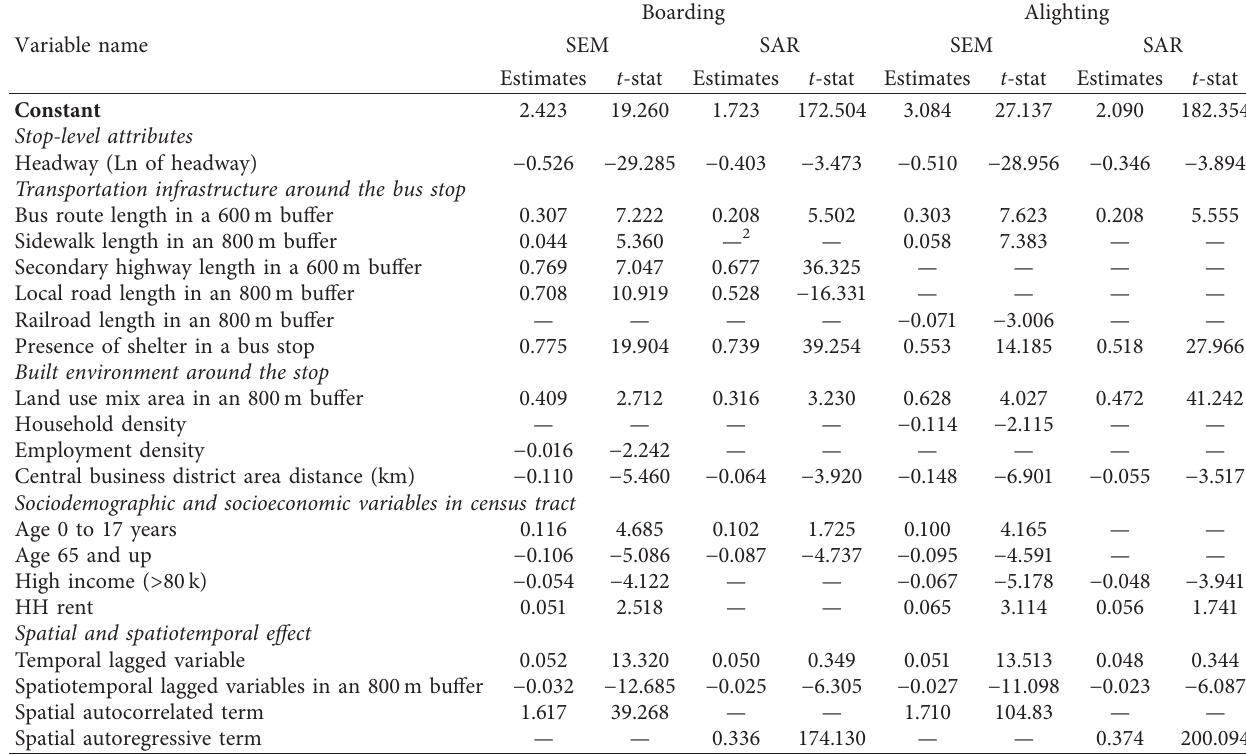
Table 3: Spatial Error Model (SEM) and Spatial Lag Model (SAR)